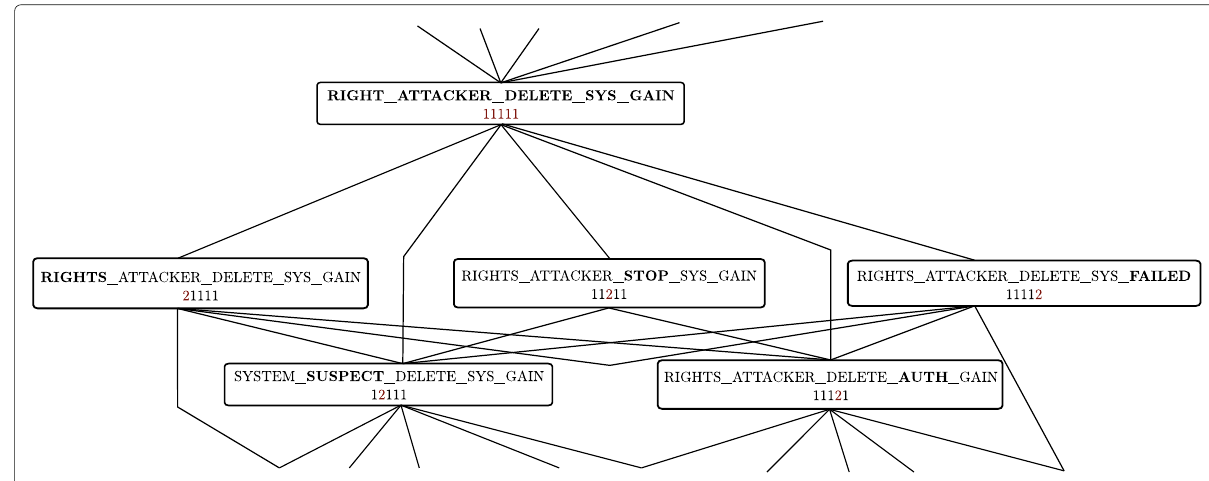
Fig. 8 Example of a Galois lattice for the reconstruction of a malicious event sequence